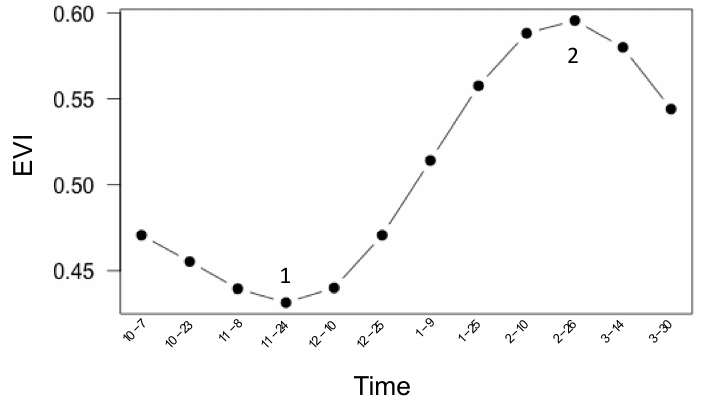
Figure 2. Example splined MODIS EVI phenology from Punjab, exhibiting characteristics of a cropped pixel as defined using MSA. Cropped pixels exhibit an increase in EVI representing green up after sowing (point 1) as well as a peak in EVI towards the end of the growing season due to crop senescence and harvest (point 2).